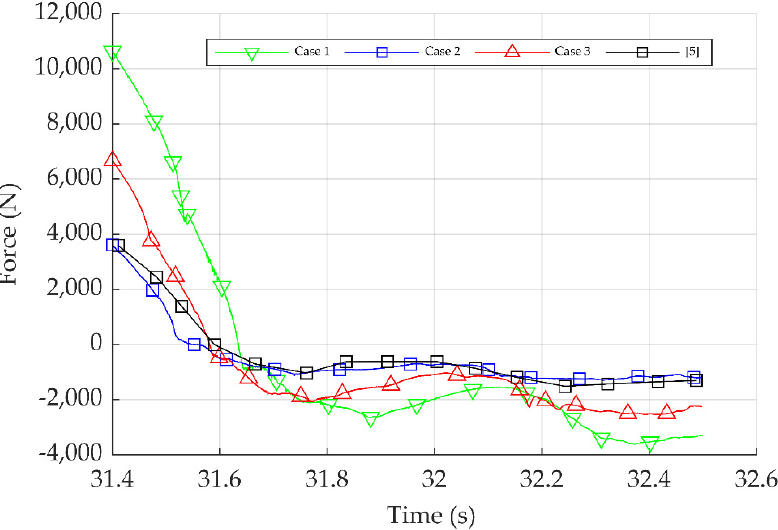
Figure 18. Comparison of the secondary load at the different substructures in the x-direction and the results of [5]. Table 14. Comparison of the magnitude of the secondary load for different cases.